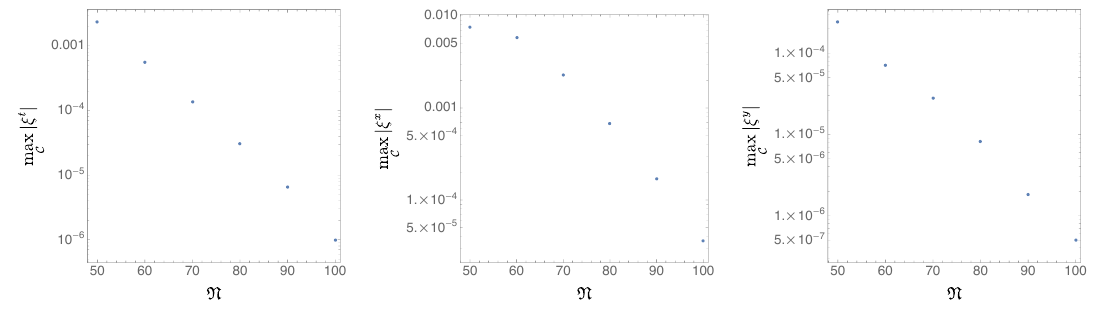
Figure 9 . Convergence properties of the non-vanishing components of DeTurck vector (cid:24) a , as a function of the number of grid points N . From left to right, we plot in a logarithmic scale max C j (cid:24) t j , max C j (cid:24) x j , max C j (cid:24) y j , with C being the domain of outer communications. All plots were generated using (cid:28) = 0 : 665557.